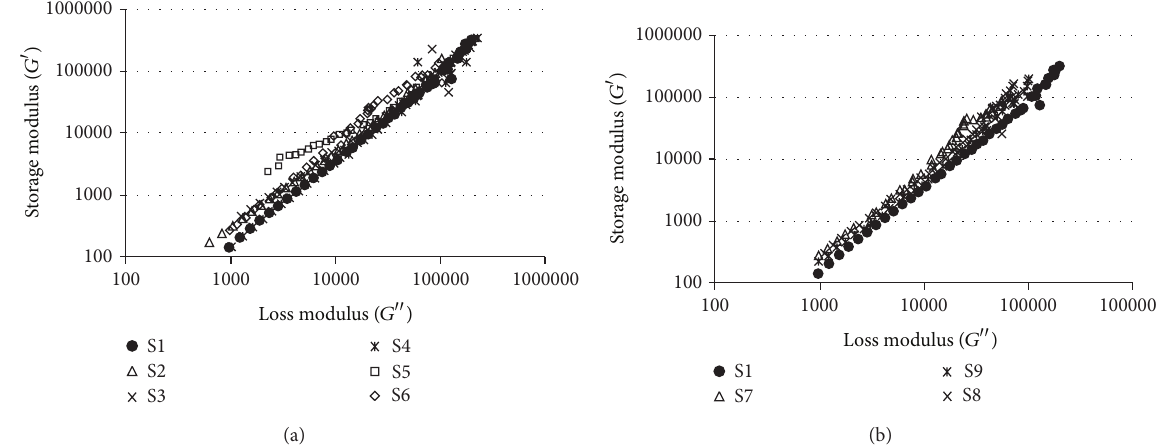
Figure 4: 𝐺 󸀠 versus 𝐺 󸀠󸀠 curve for (a) control and blend samples with NIR-reflective pigments and (b) control with NIR reflective and other UV additives.